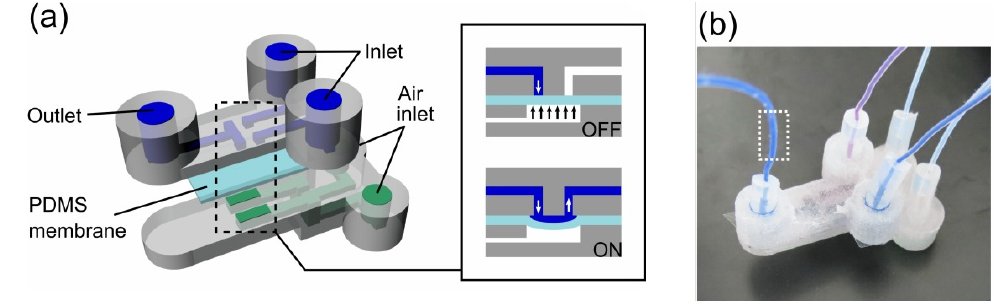
Figure 21. ( a ) CAD design of flow selector device using PDMS membrane valve. Valves are closed when air pressure is applied from the bottom channel. When opened, aqueous phases pumped at a constant pressure flow through the valve; ( b ) 3D ‐ printed flow selector device. (Reproduced with permission from [24].)